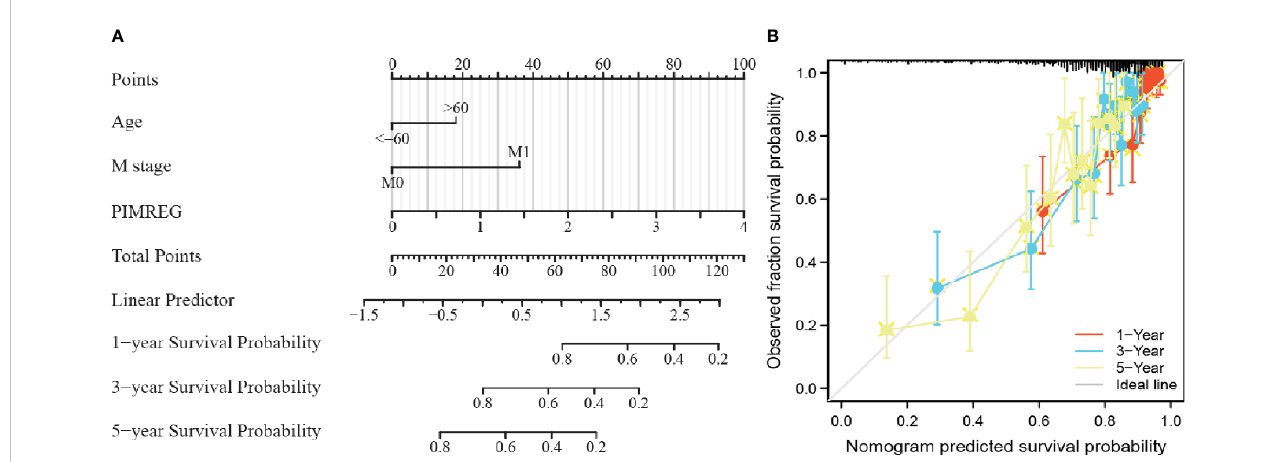
FIGURE 5 Establishment of a prognostic prediction nomogram and calibration plots about ccRCC. (A) Nomogram for predicting 1-, 3-, and 5-year OS probability for ccRCC patients. (B) Calibration plot of the nomogram for predicting the 1-, 3-, and 5-year OS probability. ccRCC: clear cell renal cell carcinoma; OS: overall survival.